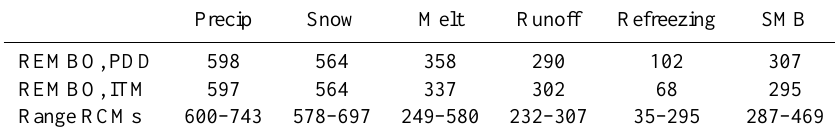
Table 2. REMBO diagnosed mass balance components for the present-day ice sheet compared to the range of RCMs, composed of results from PolarMM5 (Box et al., 2006), MAR (Fettweis, 2007) and RACMO2/GR (Ettema et al., 2009). All values are in